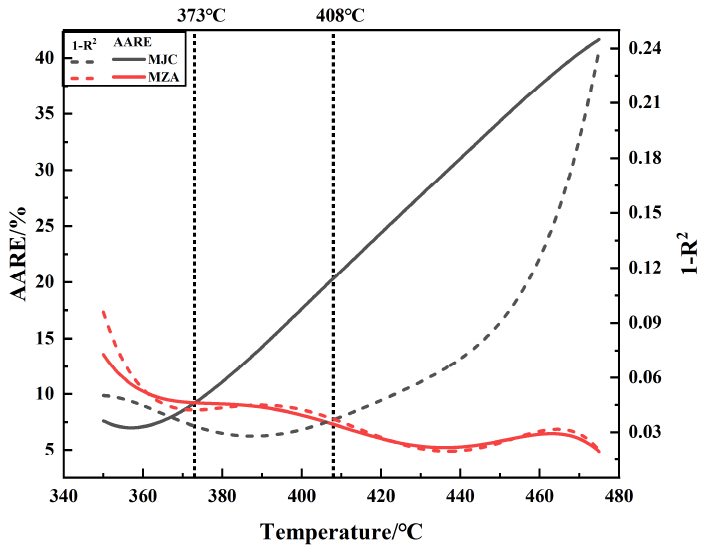
Figure 19. The effect of deformation on the accuracy of the MJC and MZA models.